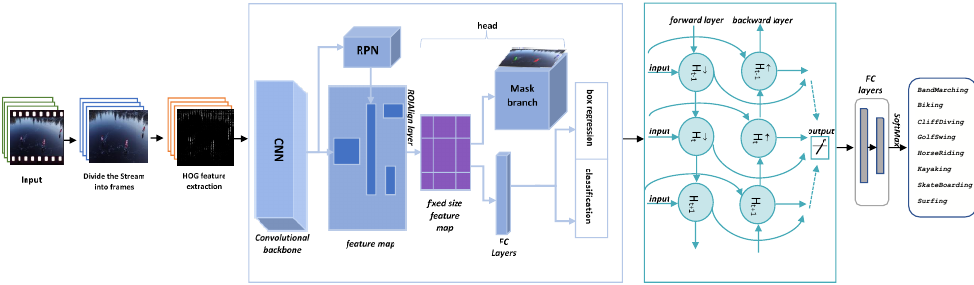
Figure 1. Human activity recognition in UAV videos using HOG, Mask-RCNN, and Bi-LSTM